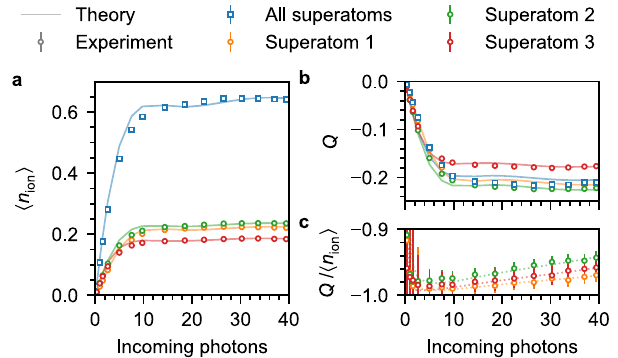
Fig. 3 Probing the absorber states via fi eld ionisation of atoms in j r i . The blue squares correspond to the combined ion signal from all three absorbers, while the yellow, green and red circles correspond to the statistics for the fi rst, second and third absorber only. a Mean detected ions 〈 n 〉 vs. mean incoming photons for n = 3. The variation in the detected ion sub ions for the individual absorbers are the result of a position-dependent detection ef fi ciency ( ‘ Methods ’ ). The shaded line shows the Rydberg population predicted by the three-level model scaled by the corresponding detection ef fi ciency. b Mandel- Q parameter Q for the same ion data as in ( a ). c Ratio Q / 〈 n ion 〉 for the individual absorbers. The dotted line shows the results of the model with added noise due to double excitation and dark counts. Error bars correspond to one standard error and are smaller than the markers for most data points in ( a ) and ( b